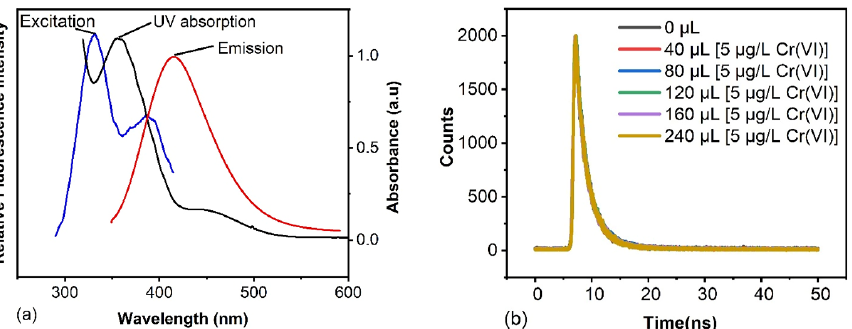
Figure 6. ( a ) UV-Vis absorption spectra of Cr(VI), fluorescence excitation spectra, and emission spectra of the N,Zn-doped fluorescent carbon dots in aqueous solution and ( b ) time-resolved decay of the N,Zn-CDs system at different volumes of 5 µ g/L Cr(VI) concentrations.